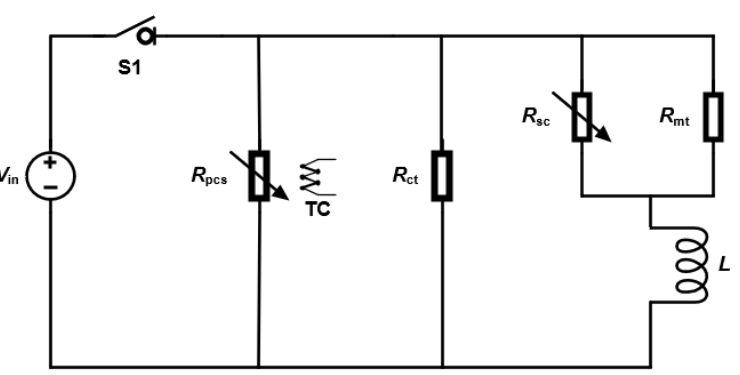
Figure 17. Circuit model of the HTS closed-loop coils.